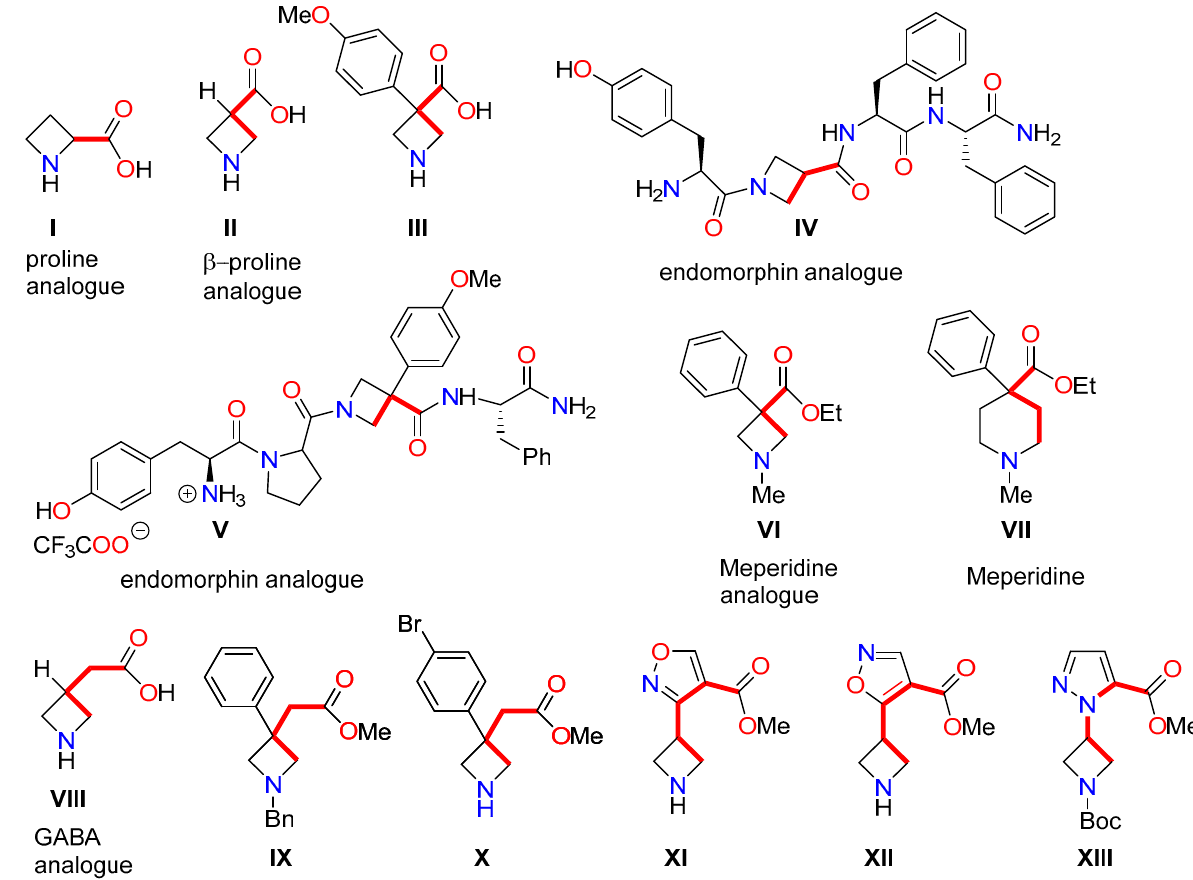
Figure 1. Azetidine amino acid derivatives and peptide